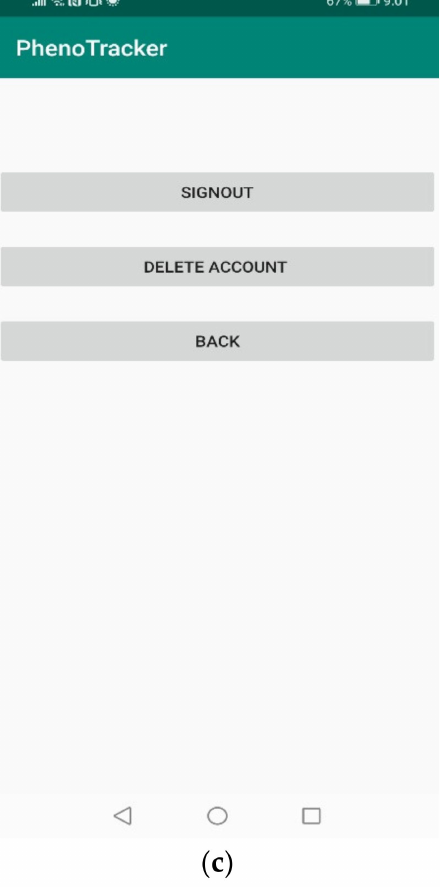
Figure 4. ( a ) Emergency alert before sending the any report. Factors covered: Theme, Altruistism and Situatedness. ( b ) Auto location pick with manual selection of location feature. Factors covered: UI, Sense of Community, Altruistism and Situatedness. ( c ) Sign out and Delete Account features. Factors covered: